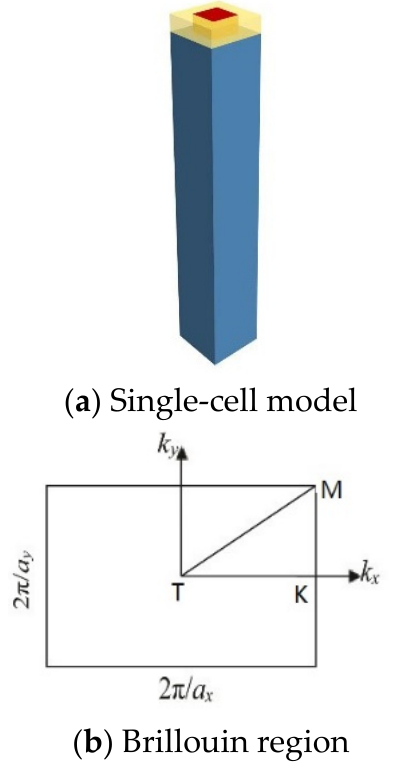
Figure 3. Single-cell model and Brillouin region.